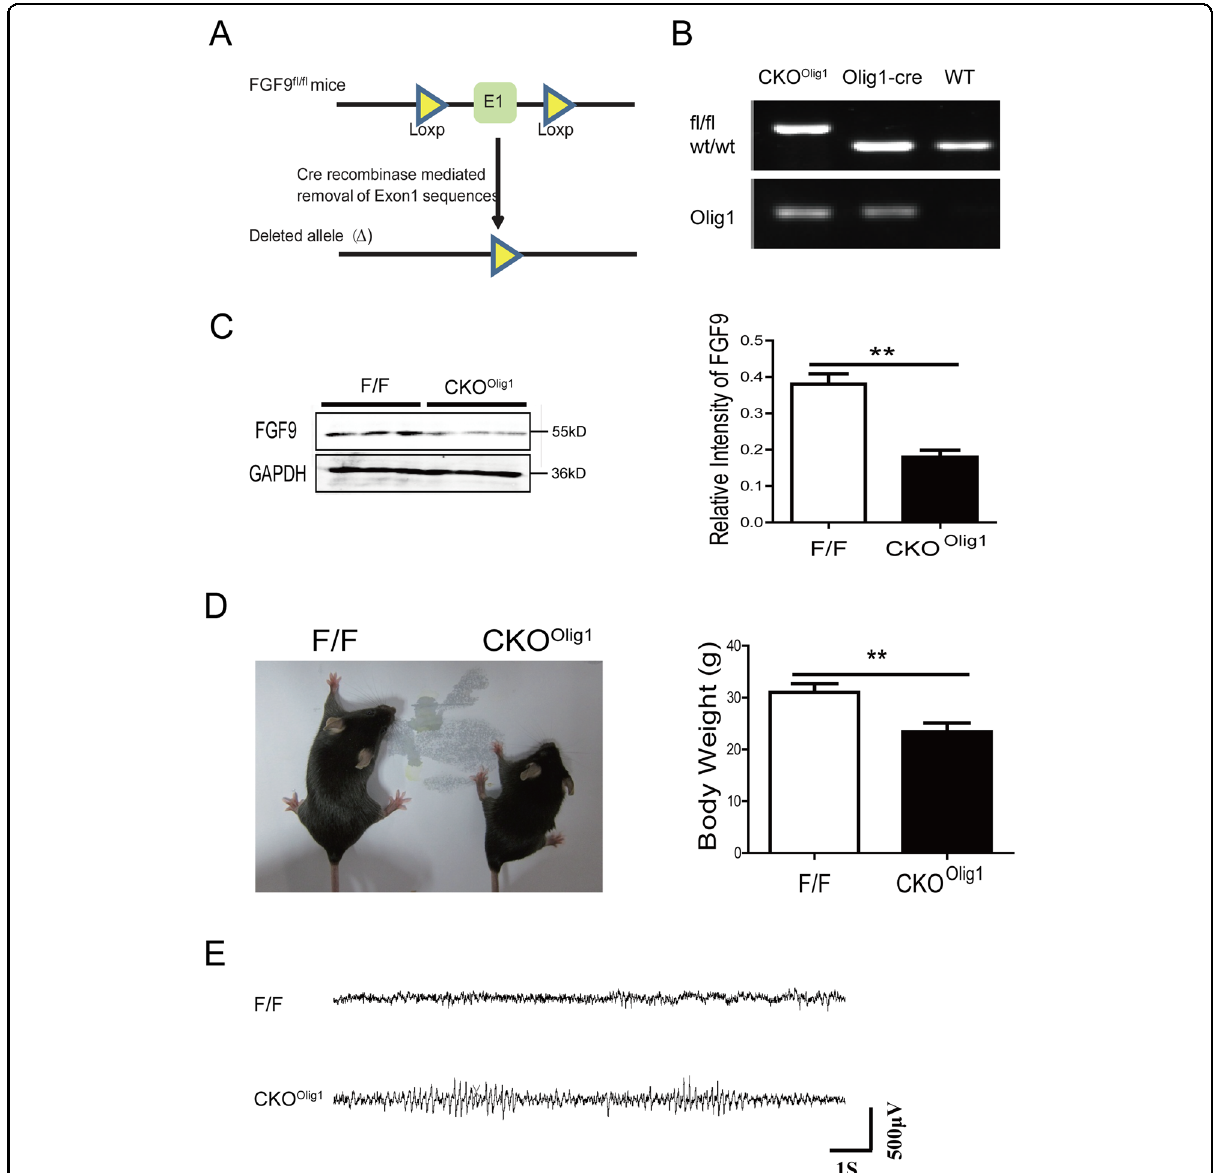
Fig. 1 Fgf9 CKO in Olig1 -Cre mice causes epilepsy. A Schematic diagram describes the design of the fl oxed and CKO Fgf9 allele. Coding exons are shown in green boxes. B PCR analyses show the genotyping in the Fgf9 loxP/loxP Olig1 -cre ( CKO Olig1 ), Olig1-Cre , and wild-type mice. C Western blot analyses demonstrate a decrease in FGF9 expression in the CKO Olig1 brain compared to that in Fgf9 fl ox/ fl ox ( F/F ) controls at 8 weeks of age. GAPDH was used as the internal loading control. D CKO Olig1 mice exhibited growth retardation at 8 weeks of age. Data are mean ± SEM for 10 mice per genotype. * P < 0.05; ** P < 0.01, nonparametric Mann-Whitney test. E EEG recordings from CKO Olig1 mice showing spontaneous seizures. Data represent mean ± SEM of triplicate